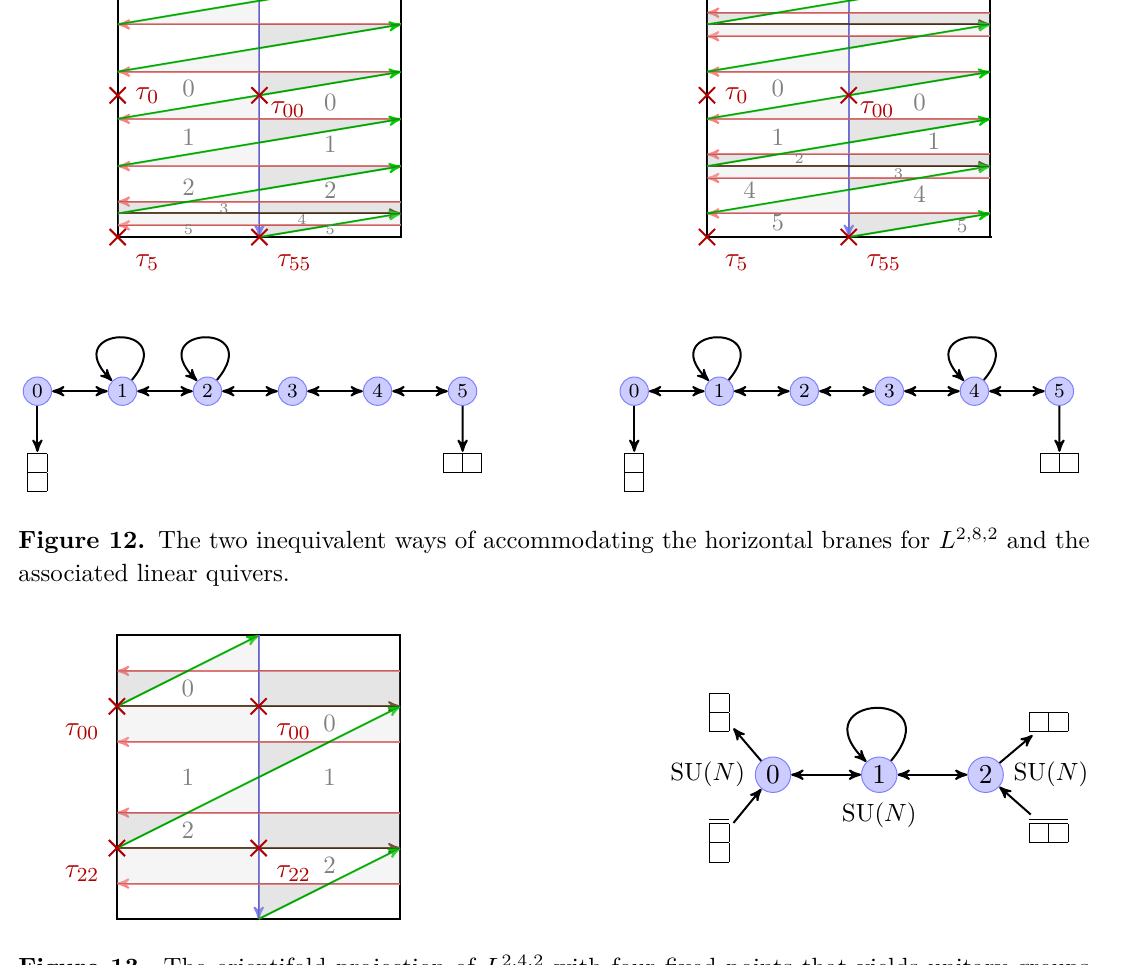
Figure 13. The orientifold projection of L 2 , 4 , 2 with four fixed points that yields unitary groups and pairs of conjugate tensor fields and the choice τ 00 = − 1 , τ 22 = +1